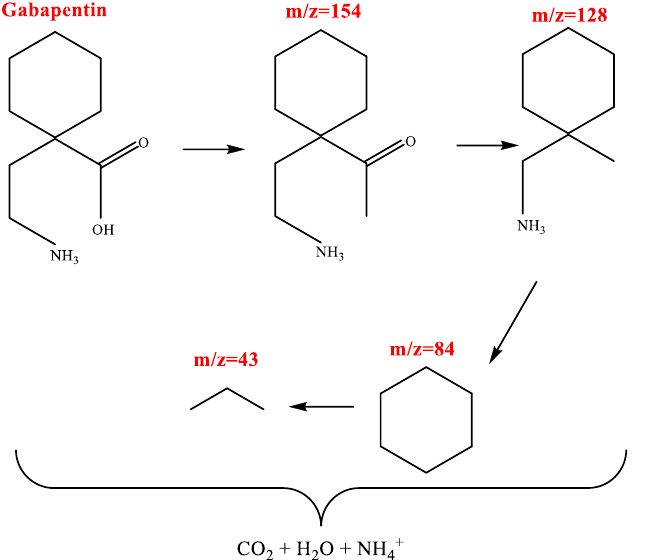
Figure 12. Proposed pathway for GBP degradation in the Cu-TiO 2 /UVA process (GPB = 10 mg/L, pH = 8, catalyst = 0.4 g/L, reaction time = 60 min). pH = 8, catalyst = 0.4 g/L, reaction time = 60